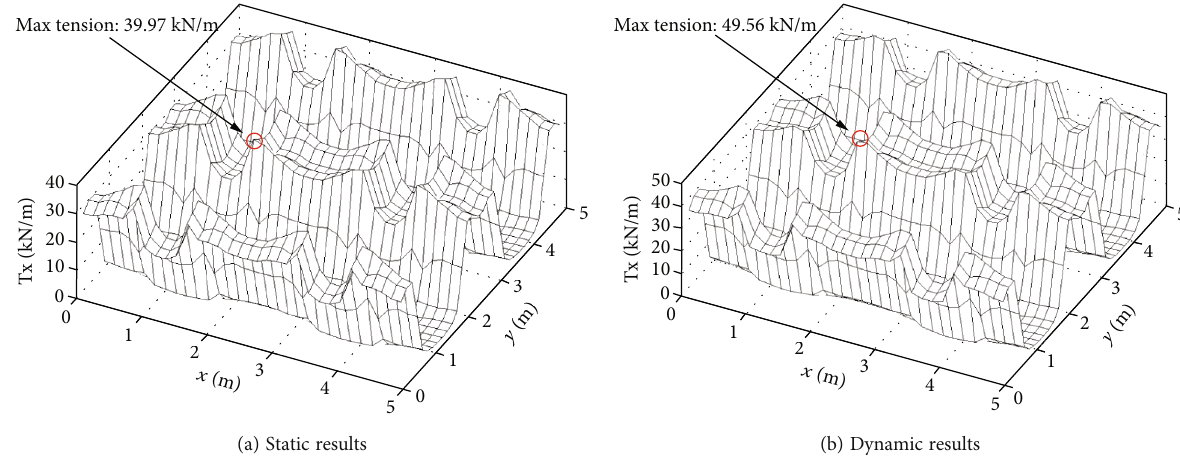
Figure 3: Tensile force of the geogrid along x direction ( s = 2 : 5 m, h = 3 : 5 m, J = 3 : 0 MN/m, υ = 60